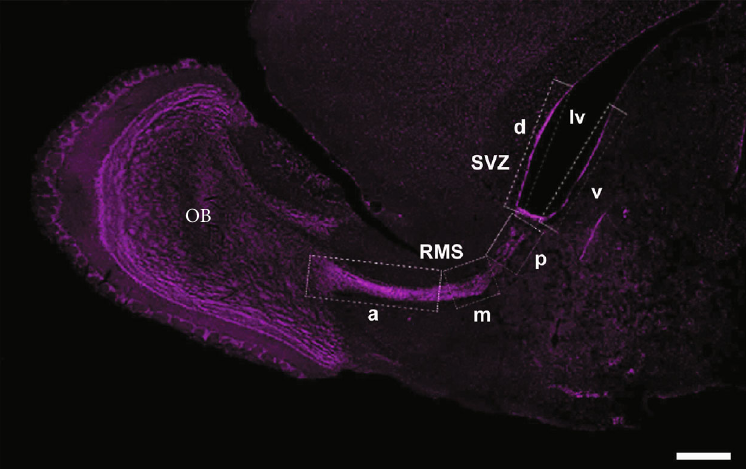
Figure 2: Sagittal section of an adult male vole brain stained with the nuclear marker Hoechst (magenta pseudocolored). White scattered rectangles indicate the subdivision of the subventricular zone (SVZ) and rostral migratory stream (RMS). SVZ subareas: d: dorsal; v: ventral. RMS subareas: a: anterior; m: medial; p: posterior. lv: lateral ventricle. OB: olfactory bulb. Photomicrographs were taken at 20x. Scale bar: 500 μ